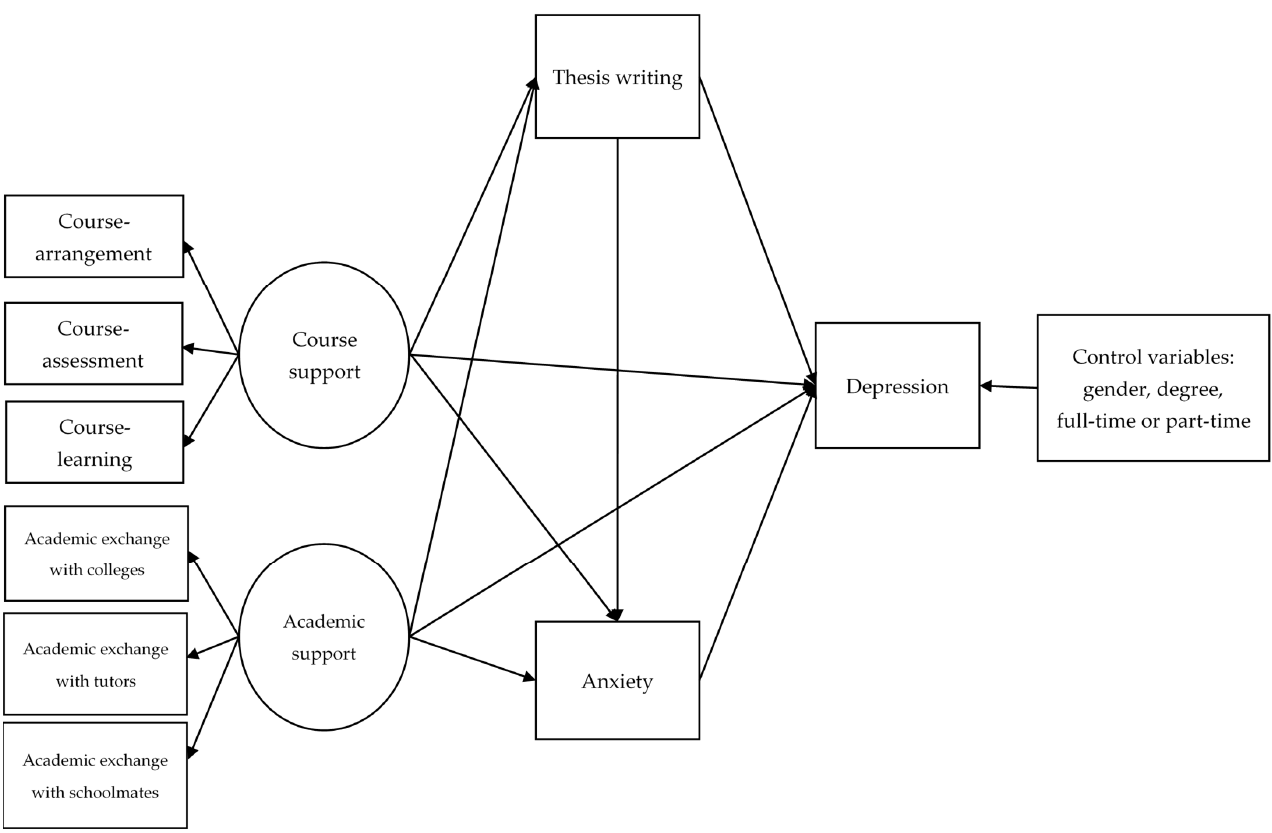
Figure 1. Conceptual model linking Course support, Academic support, Thesis writing, Anxiety and Depression.